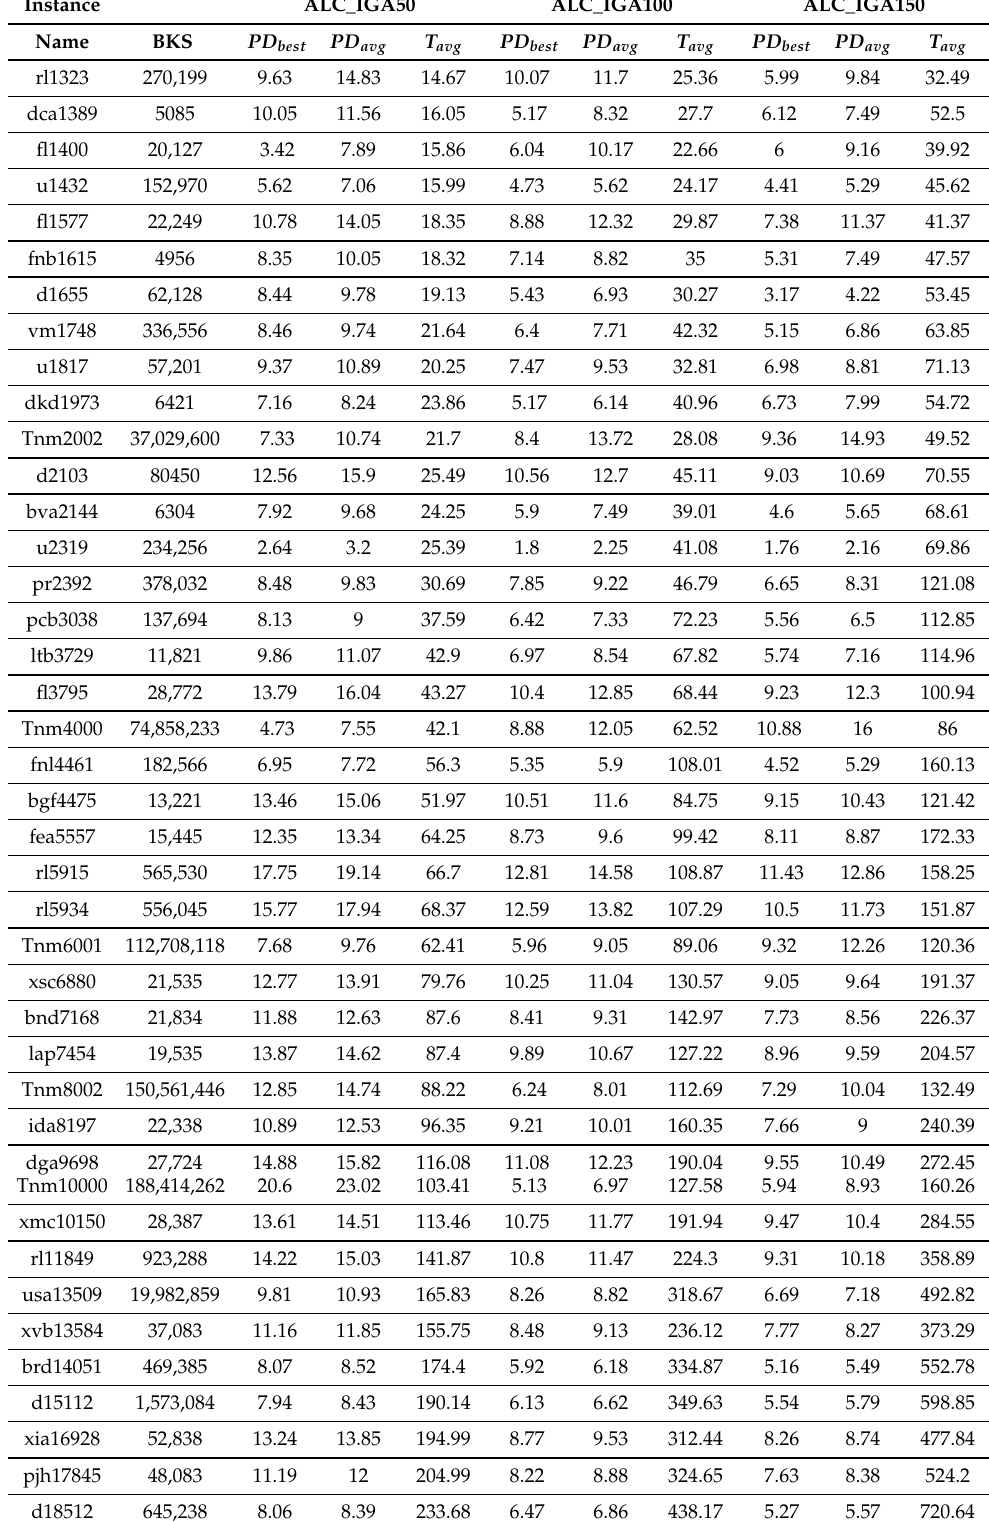
Table 4. Table 4. Comparison of results obtained by ALC_IGA in single core with M setting to 50, 100, and 150,